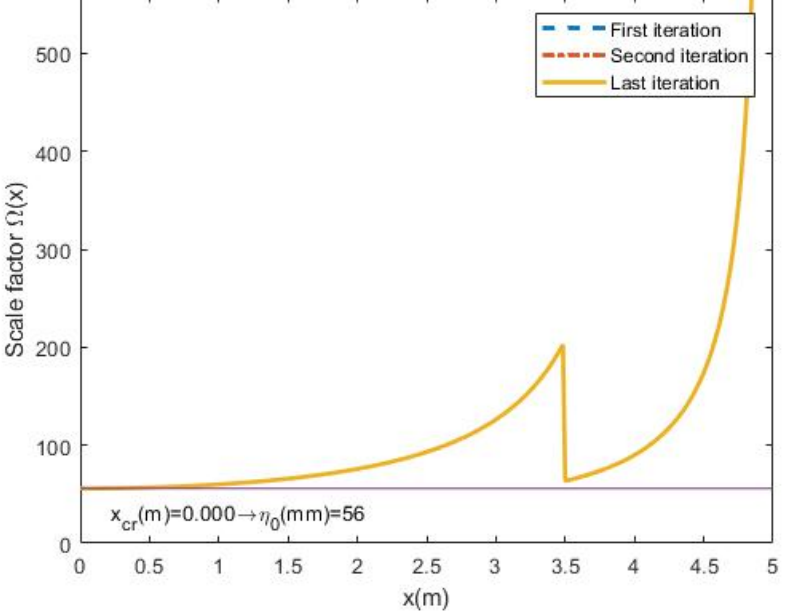
Figure 19. Example 6: UGLI imperfection η init , bending moment M , shear force V , and utilization factor U .